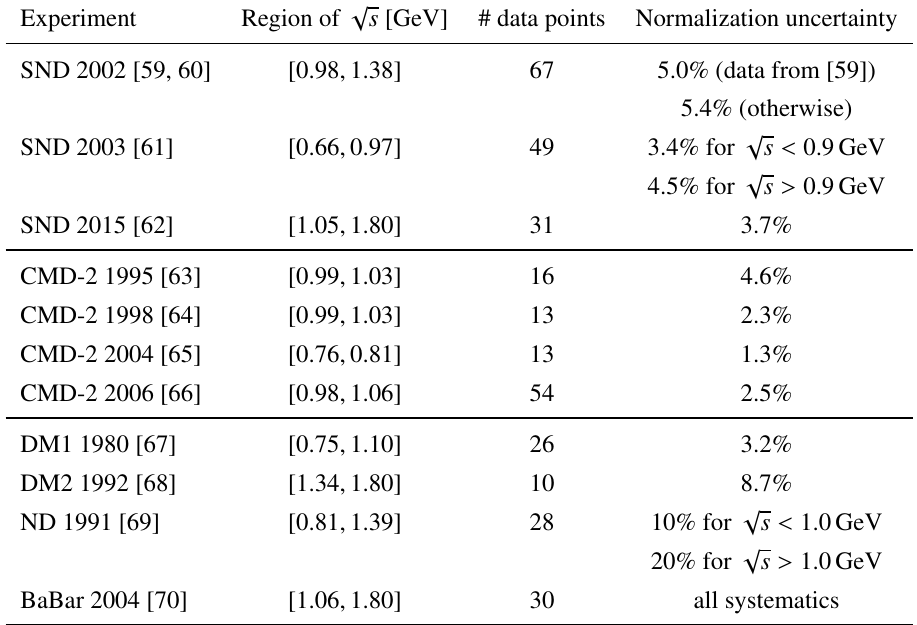
Table 1. Summary table of e + e − 3 π data sets. Only data points below 1 . 8GeV are included from [62, 68, 70]. In the last column, → normalization-type systematic uncertainties are assumed to be 100%